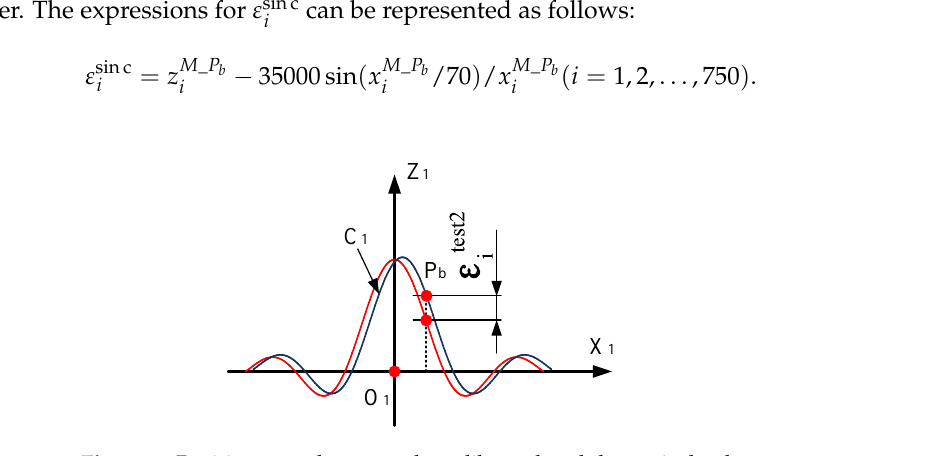
Figure 7. Position error between the calibrated and theoretical value.